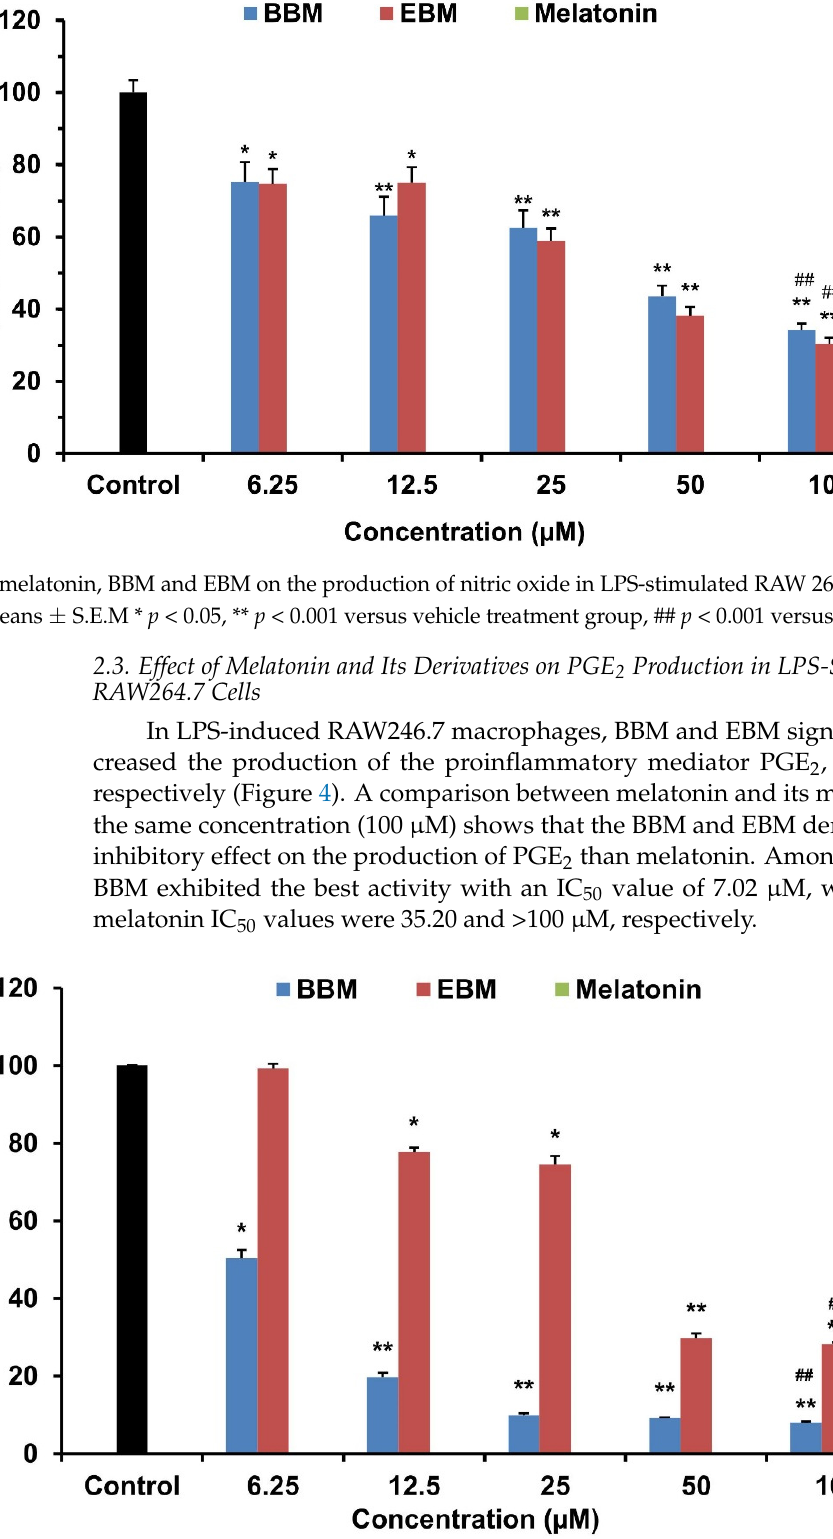
Figure 4. Effect of melatonin, BBM and EBM on the production of PGE 2 in LPS-stimulated RAW 264.7 cells. Values are expressed as the means ± S.E.M * p < 0.05, ** p < 0.001 versus vehicle treatment group, ## p < 0.001 versus melatonin 100 µM.